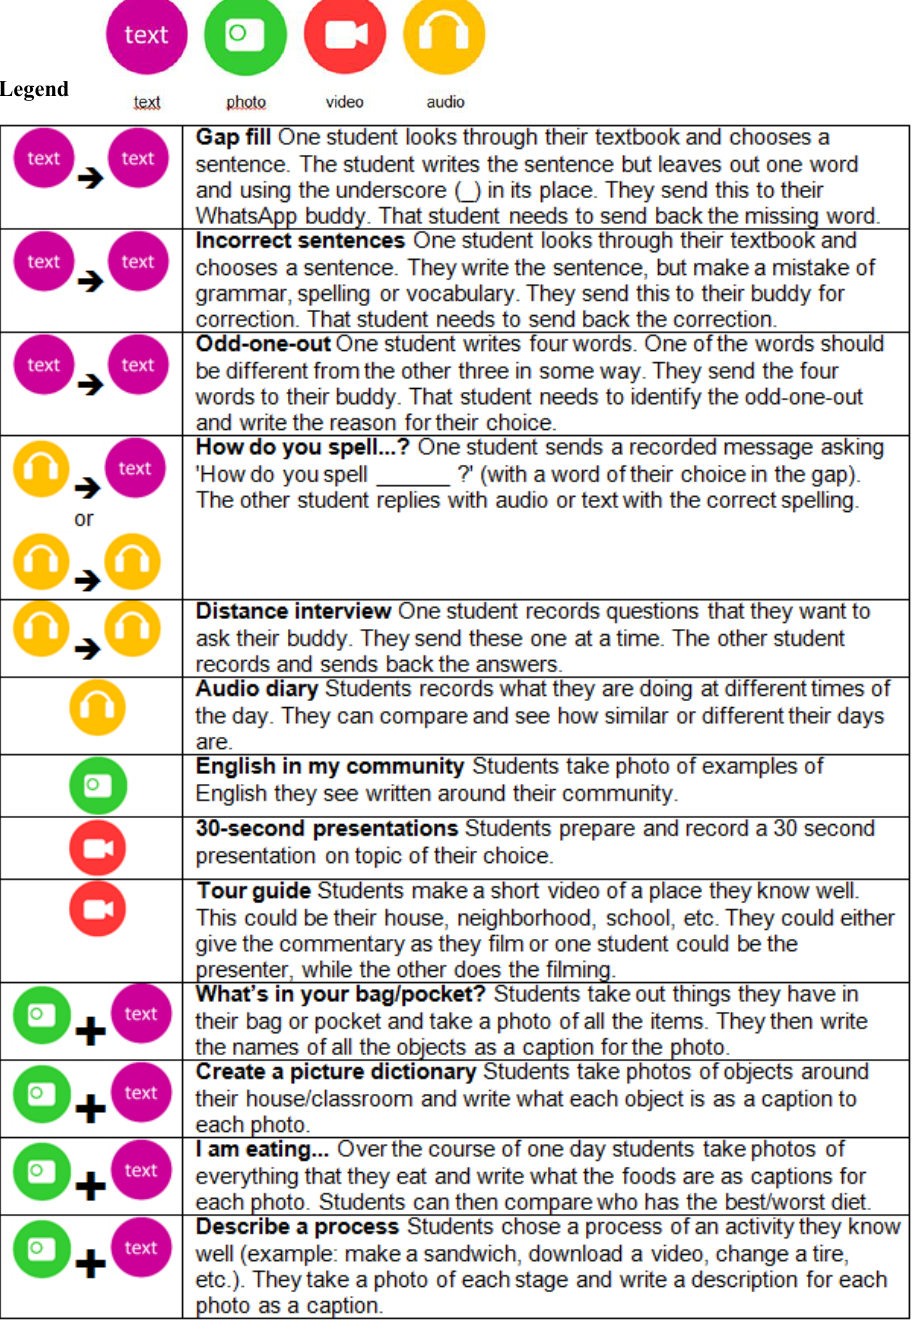
Fig. 1. Features of WhatsApp for teaching and